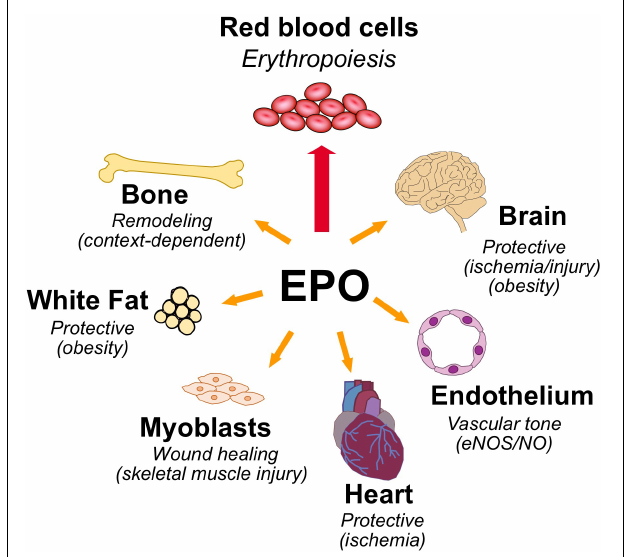
FIGURE 1 | Pleiotropic effects of erythropoietin. High level of EPOR on erythroid progenitor cells accounts for the sensitive erythropoietic response in the bone marrow to hypoxic induction of EPO. EPOR expression determines EPO response and expression beyond erythroid tissue provides for EPO response in non-hematopoietic tissues that include the following: brain for a neuroprotective and metabolic response; cardiovascular system for regulating vascular tone and oxygen delivery in endothelium and protection in heart against ischemic injury; skeletal muscle for muscle maintenance and repair; white adipose tissue for protection for inflammation associated with diet-induced obesity and fat mass accumulation, particularly in males; and bone